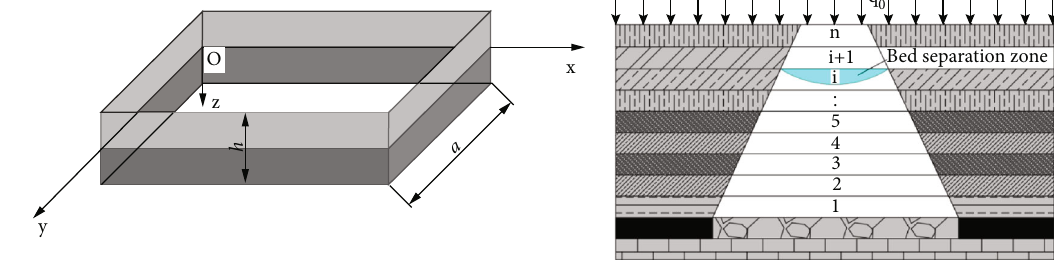
Figure 3: The spatial model of bed separation zone.